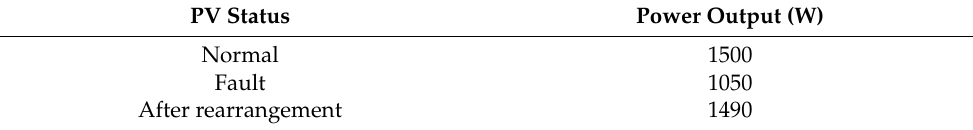
Table 1. The efficiency of the PV array after rearrangement for the same operating